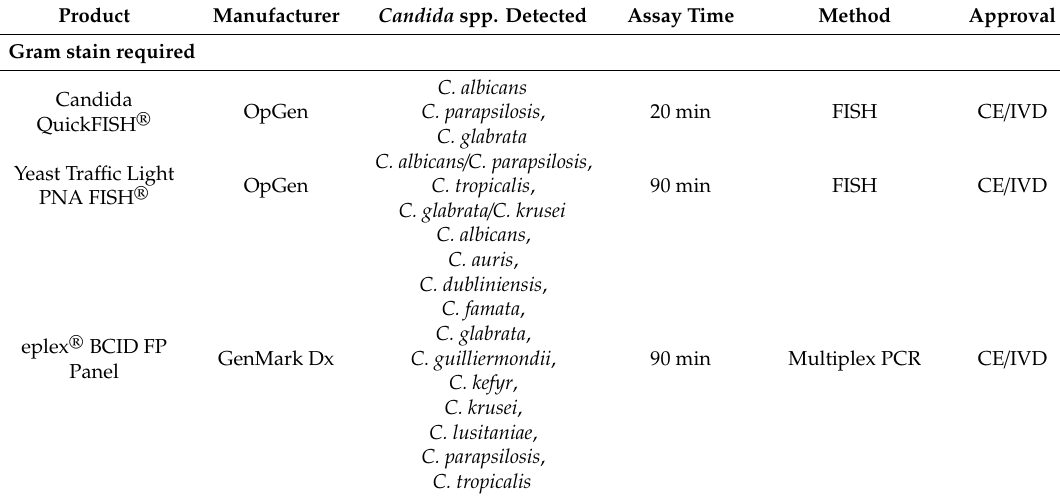
Table 1. List of blood culture-dependent